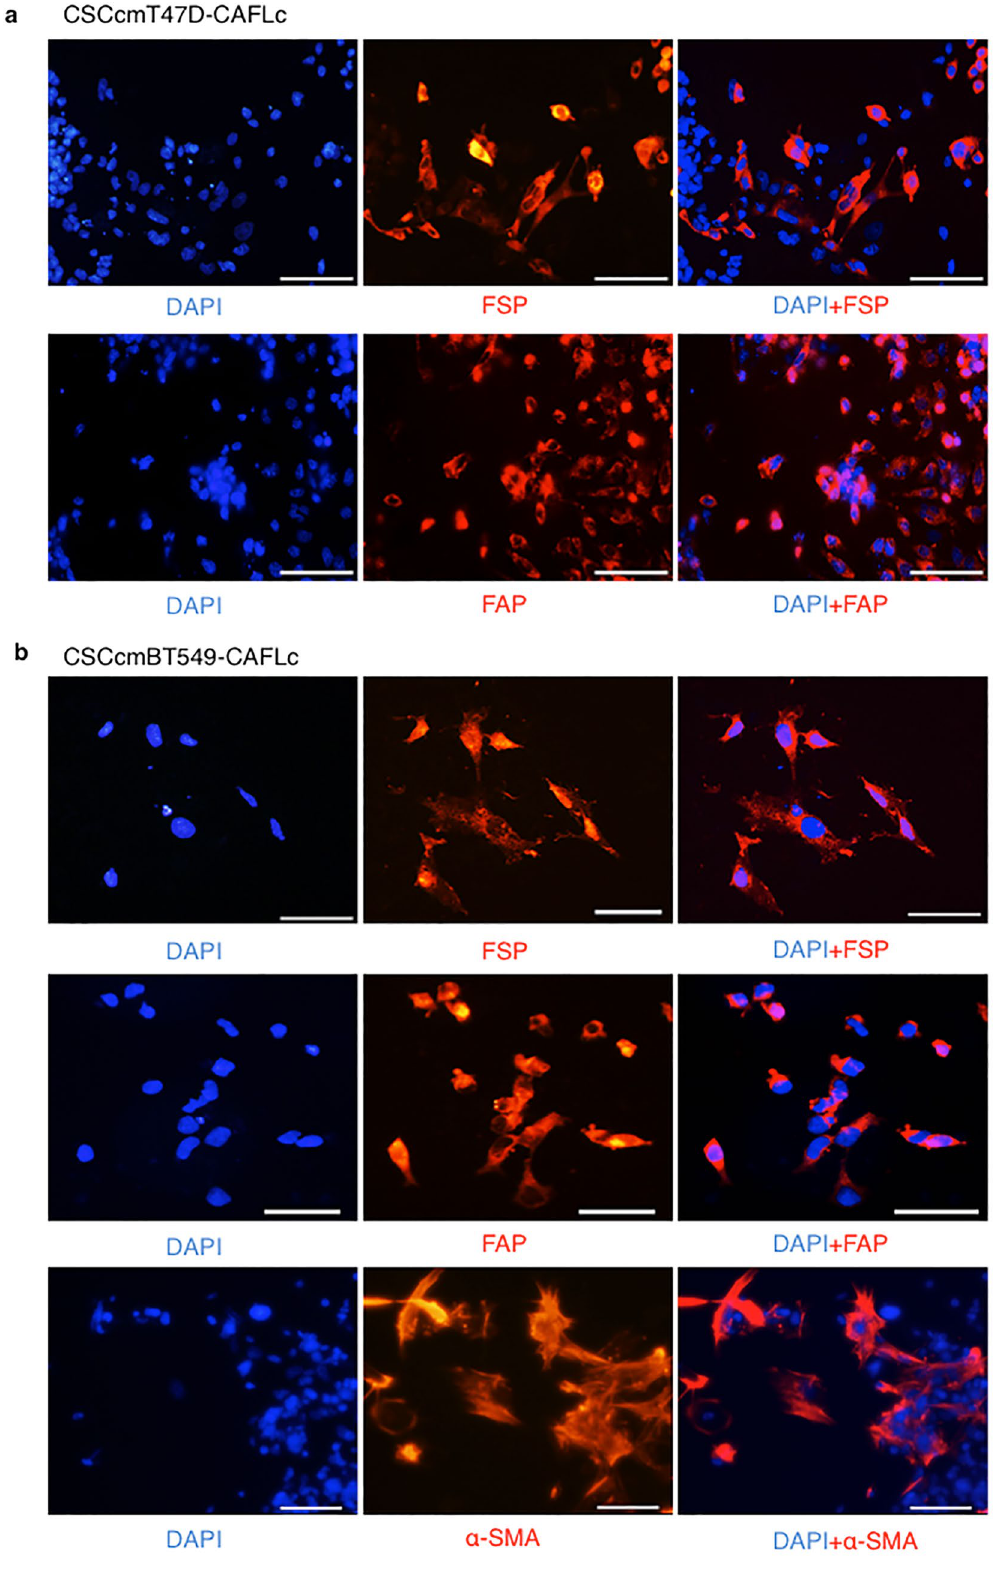
Figure 5. Immunofluorescence analysis of CAF markers. Isolated CSCcmT47D-CAFLCs ( a ) and CSCcmBT549-CAFLCs ( b ) were stained with anti-rabbit FSP1, anti-rabbit α -SMA, or anti-rabbit FAP ( red ). The nuclei were counterstained with DAPI ( blue ). Scale bars represent 50 μ